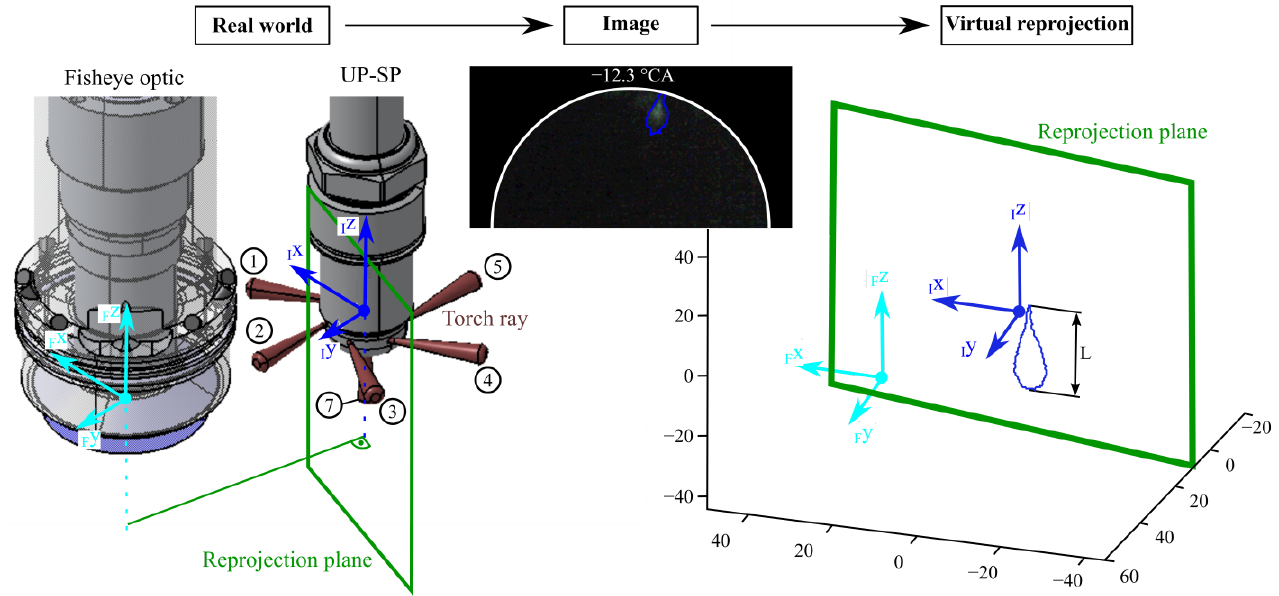
Figure 17. Proceeding of virtual reprojection to derive the torch ray length L using the visible natural chemiluminescence (numbers indicate the different torch rays).